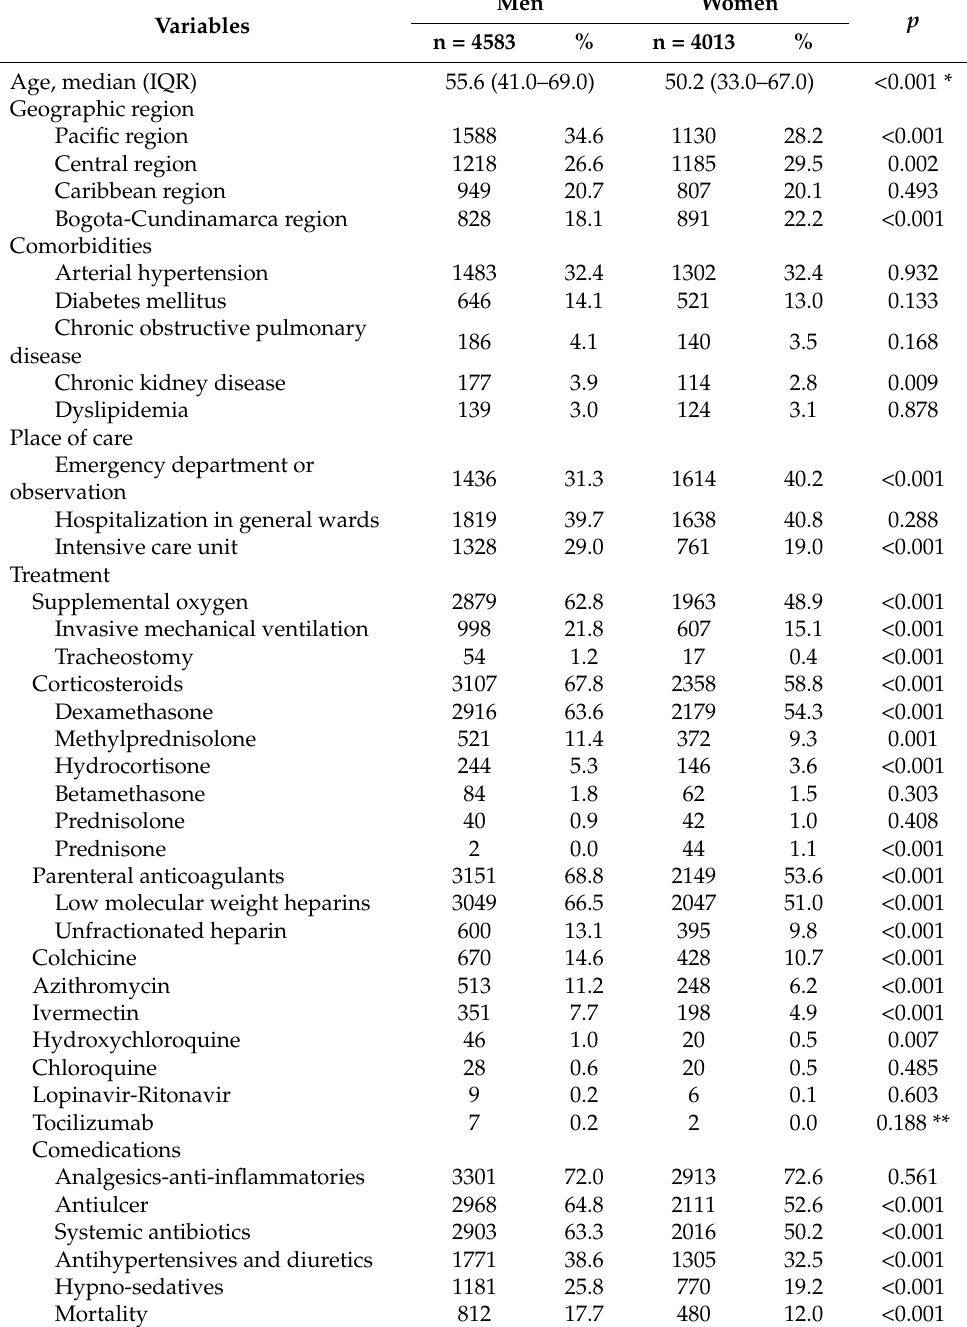
Table 1. Comparison of some sociodemographic, clinical and pharmacological variables by sex, in a group of patients with a confirmed diagnosis of SARS-CoV-2 infection, Colombia. Variables